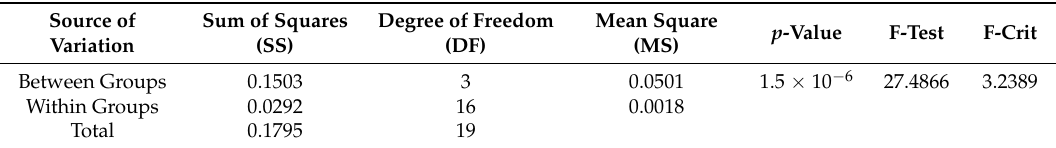
Table 3. One-way ANOVA test for sample entropy at scale 2 of MSE.